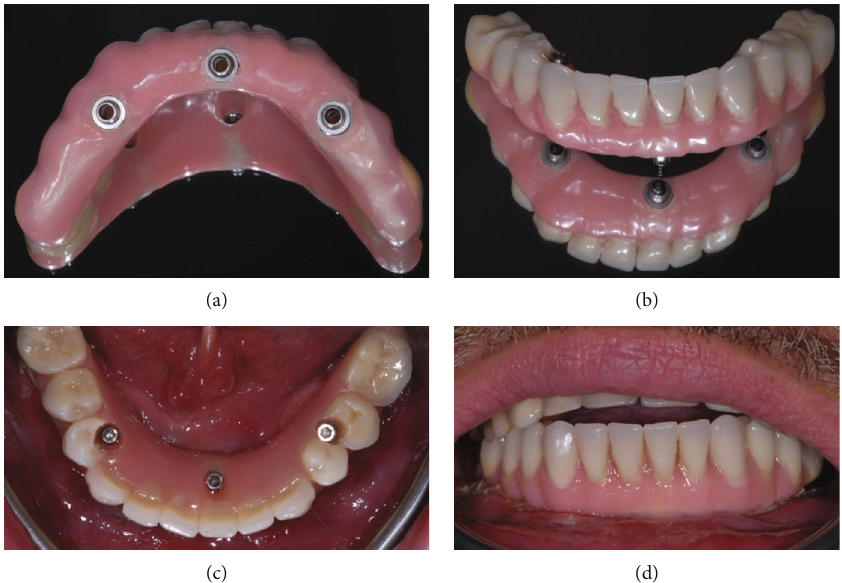
Figure 8: Extraoral view of the prosthesis before its insertion (a, b) and intraoral occlusal (c) and buccal (d) view once it has been screwed.